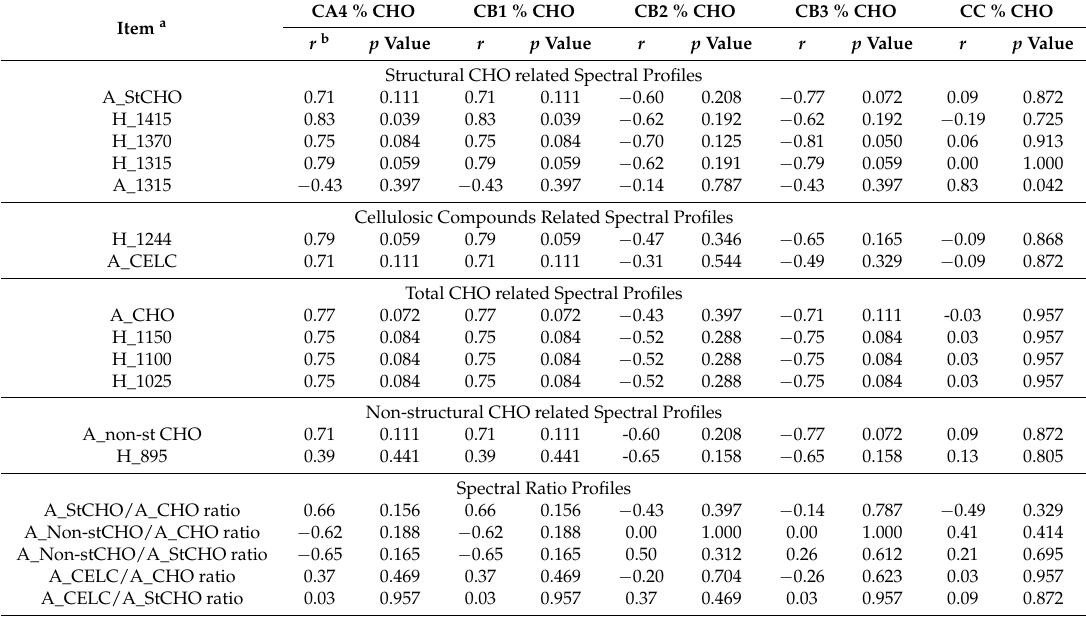
Table 4. Correlation between carbohydrate molecular spectral characteristics and carbohydrate cncps fractions in model forage ( Medicago sativa spp. Sativa : Alfalfa).